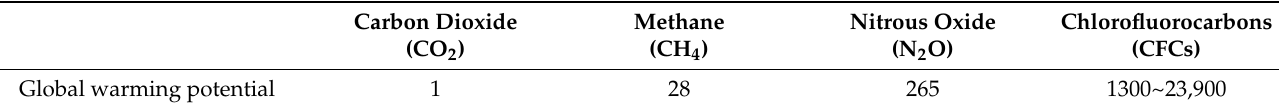
Figure 14. Portion of GWP sources for each of the alternative fuels in the well-to-tank phase (( a ) MGO, ( b ) LNG, ( c ) Hydrogen). Table 5. GWP comparison of the main greenhouse gases [28].